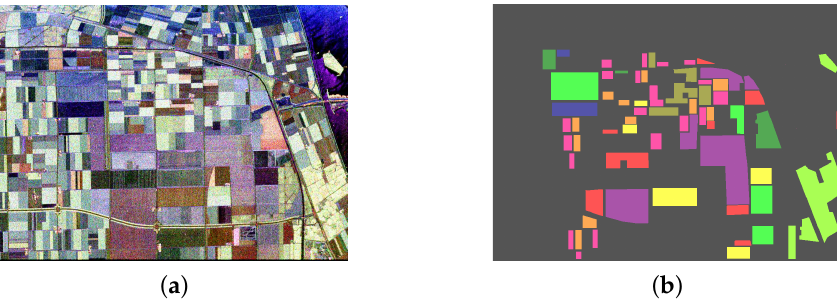
Figure 3. The Flevoland-1989 dataset. ( a ) Pauli RGB composite image. ( b ) Ground truth